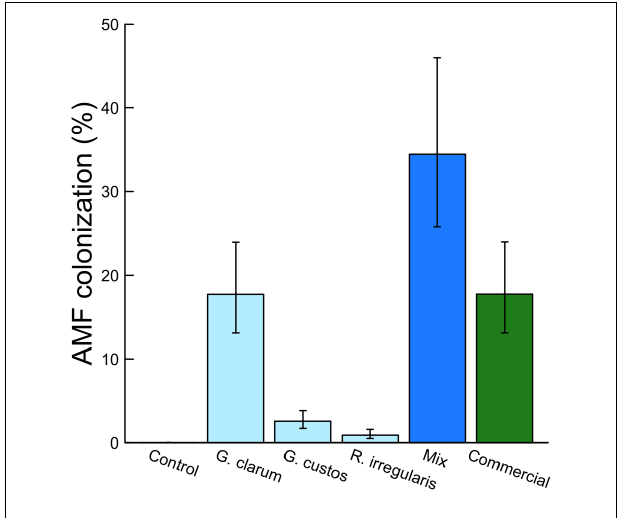
FIGURE 1 | Effects ofAMF inoculation treatments on percentAMF colonization.Values are fitted means ± 1 SE.